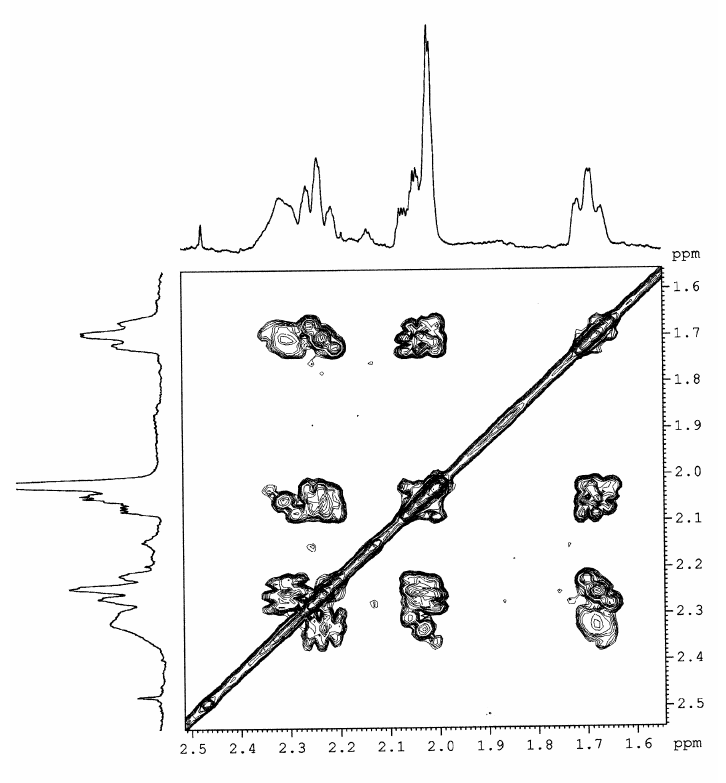
Fig. 8 Expanded section of the COSY-45 spectrum of compound 8